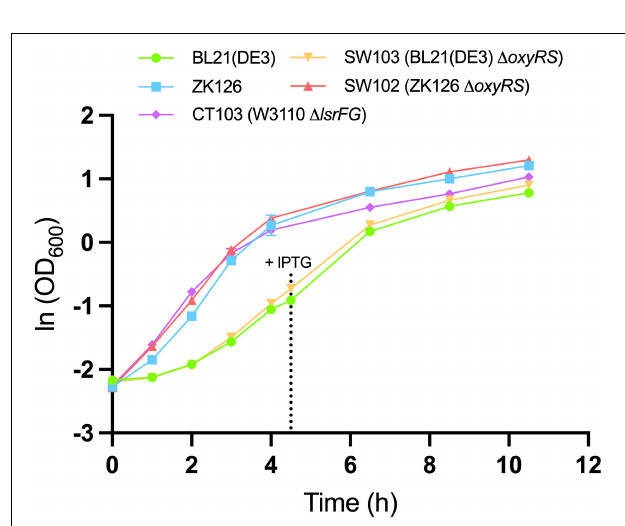
FIGURE 6 | Growth of different cell cultures. Mean OD 600 values for IPTG-induced BL21 (DE3) (green, circle), IPTG-induced SW103 (yellow, downward triangle), autoinduced ZK126 (blue, square), autoinduced CT103 (purple, diamond), and autoinduced SW102 (red, upward triangle) cultures. Both BL21 (DE3) and SW103 cultures were induced with 1mM IPTG at OD 600 = 0.4. Error bar represents the standard deviation between replicates ( n =